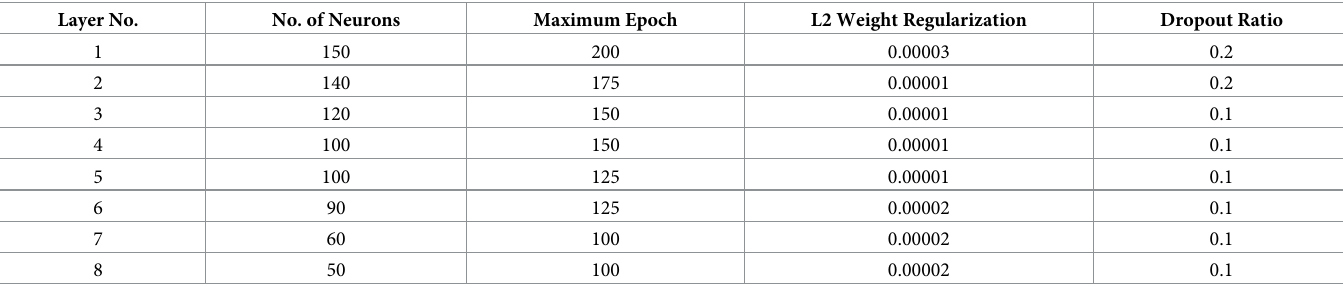
Table 4. Precise fine-tuned parameters for Offshore Windfarm 3. Layer